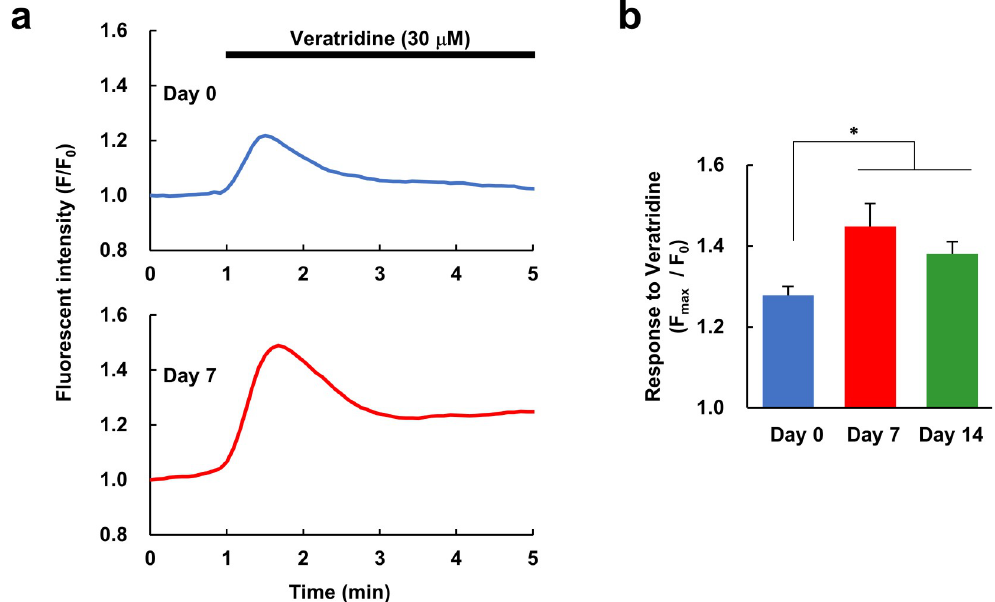
Fig 4. Ca 2+ response to the voltage-gated Na + channel activator veratridine. (a) Representative Ca 2+ responses to veratridine (30 μ M), an activator of voltage-gated Na + channels, in undifferentiated (Day 0) and differentiated (Day 7) hDPSCs. (b) Comparison of the amplitude (F max /F 0 ) of Ca 2+ responses evoked by veratridine in Day 0, 7 and 14 hDPSCs (n = 180, 152, or 84 cells, respectively, from 5–8 different experiments for each condition). Error bars, standard error of the mean. � P < 0.05 compared to Day